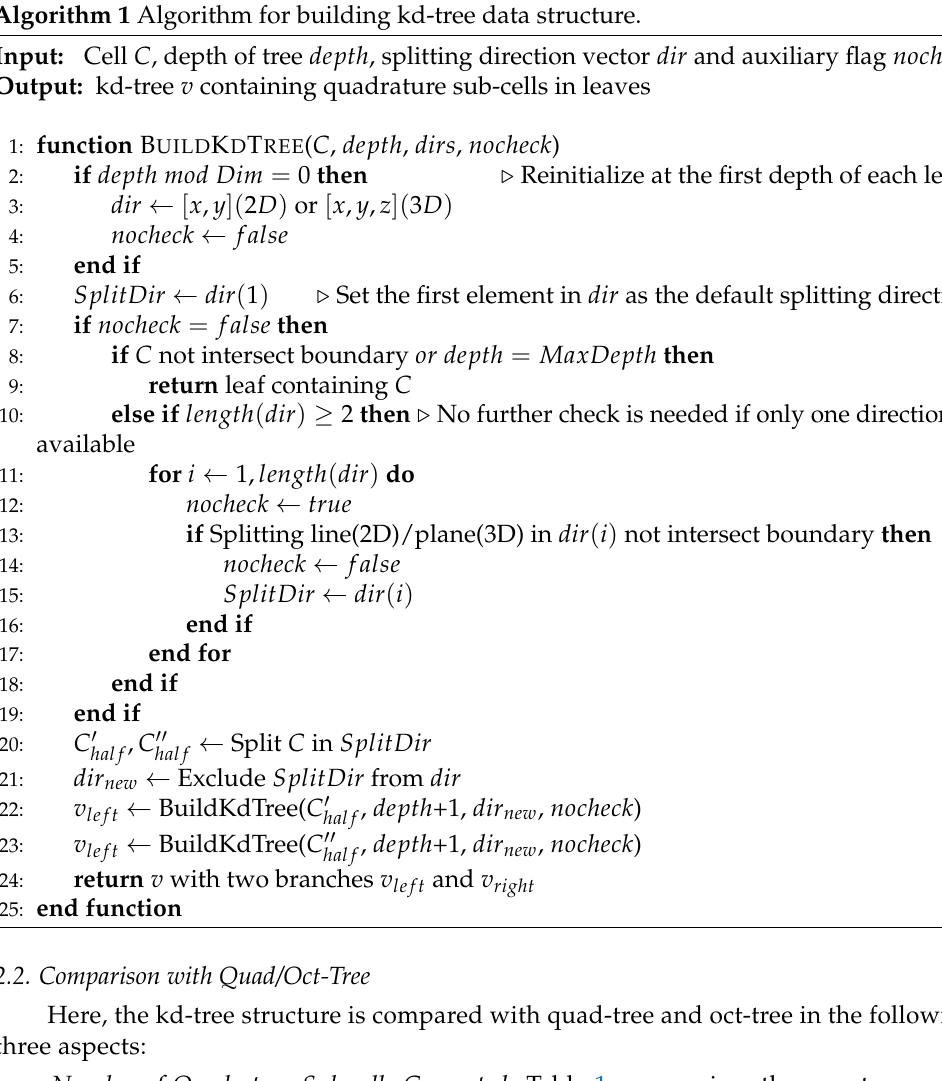
Algorithm 1 Algorithm for building kd-tree data structure.